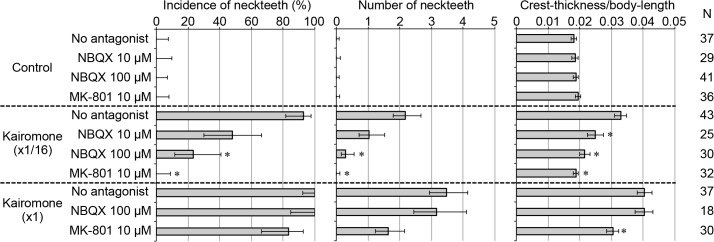
Effect of ionotropic glutamate receptor antagonists on the three different indicators of the defensive morph.The indicators are incidence of neckteeth (left), average number of neckteeth (center), and crest thickness normalized to body-length (right). Error bars indicate 95% confidence intervals. Asterisks indicate significant differences (p < 0.01) as compared with Daphnia exposed to the same kairomone conditions without antagonists (-). N: number of specimens.